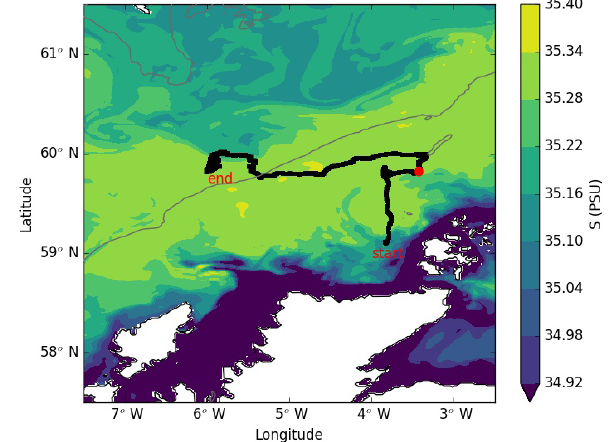
Figure 14. Glider 553 trajectory. The glider started the measure- ments close to the Scotland coast and then moved towards the shelf break. The black line is the glider trajectory. The grey line rep- resents the 200m isobath. The red dot is the glider position on 23 May 2017. The field in the background is the AMM15 salinity on 23 May at